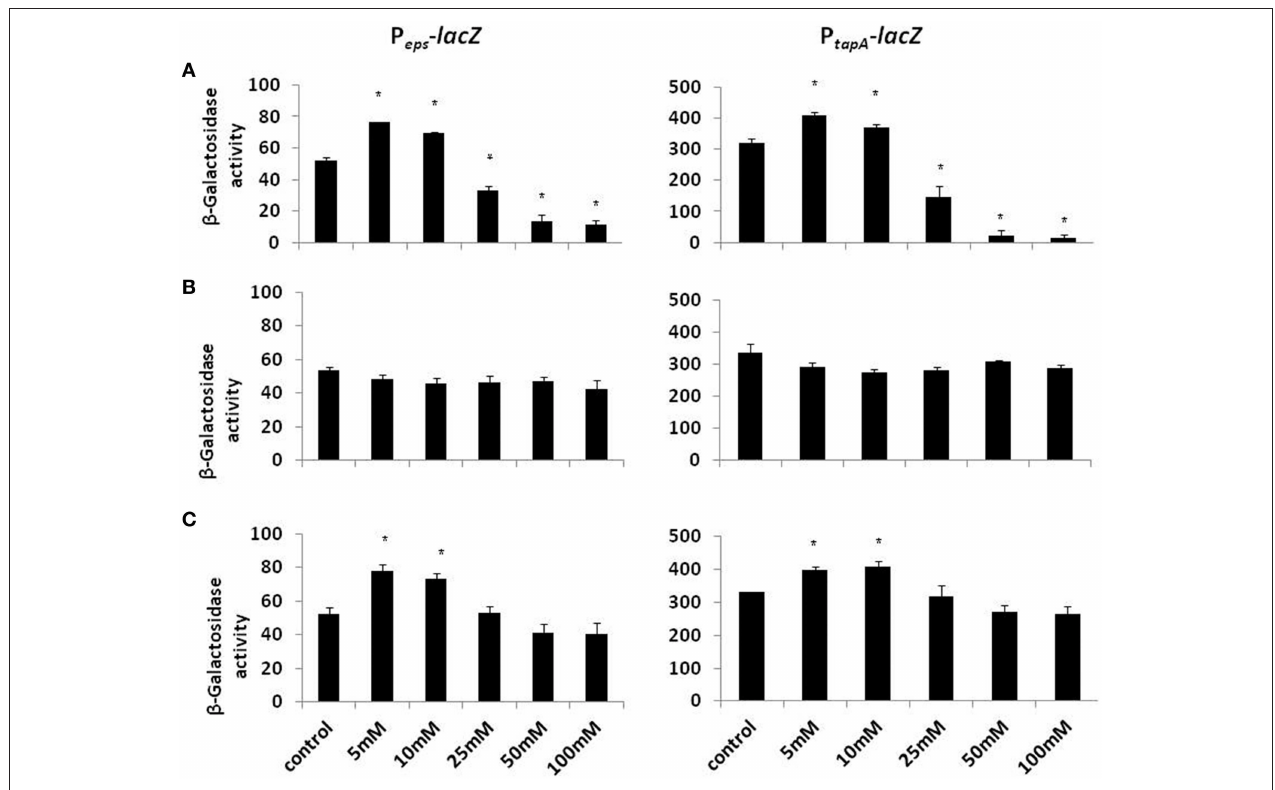
FIGURE 2 | The effect of Mg 2 + , Ca 2 + , and Na + ions on transcription of the operons responsible for the matrix production. Transcription of the operons responsible for the matrix production is differentially regulated in response to (A) Mg 2 + , (B) Na + , and (C) Ca 2 + ions. The left panel shows results from RL4548 cells that bear the P eps - lacZ transcriptional fusion and the right panel demonstrates results from RL4582 cells that bear the P tapA - lacZ transcriptional fusion;. * P -value < 0.05 compared to